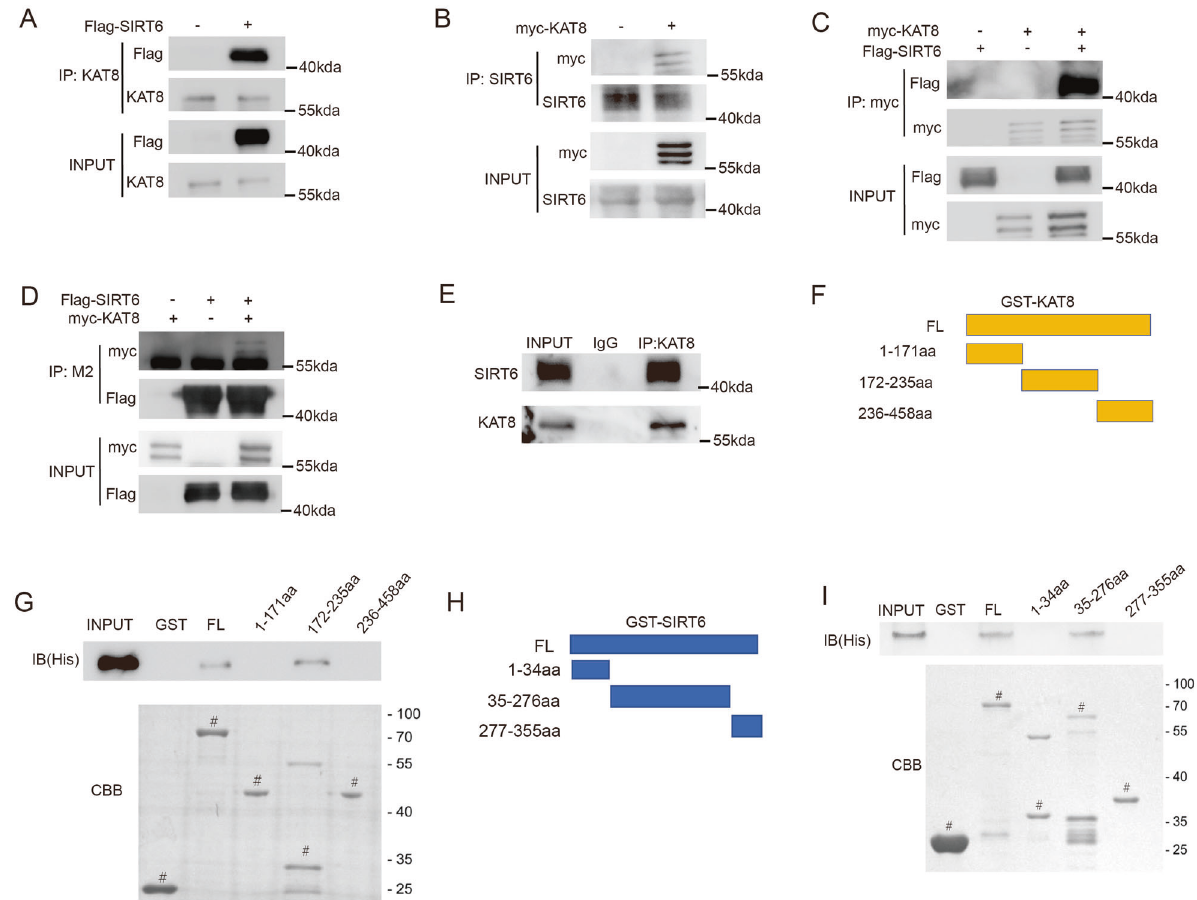
Fig. 4 KAT8 interacts with SIRT6 in vivo and in vitro. A , B HCT116 cells were transfected with Flag-SIRT6 plasmids (A) or myc-KAT8 plasmids (B), and then proteins were extracted for Co-IP to detect the semi-exogenous interaction between KAT8 and SIRT6. C , D HCT116 cells were transfected with Flag-SIRT6 and/or myc-KAT8 plasmids, and then proteins were extracted for Co-IP to detect the exogenous interaction between KAT8 and SIRT6. E Protein of HCT116 cells was extracted for Co-IP to detect the endogenous interaction between KAT8 and SIRT6. F Schematic of plasmids encoding KAT8. G GST-KAT8 FL or fragments were incubated with His-SIRT6, and Western blotting or Coomassie staining was performed to detect the direct binding of KAT8 and SIRT6 in vitro. H Schematic of plasmids encoding SIRT6. I GST-SIRT6 FL or fragments were incubated with His-KAT8, and Western blotting or Coomassie staining was performed to detect the interaction. # indicates the speci fi c